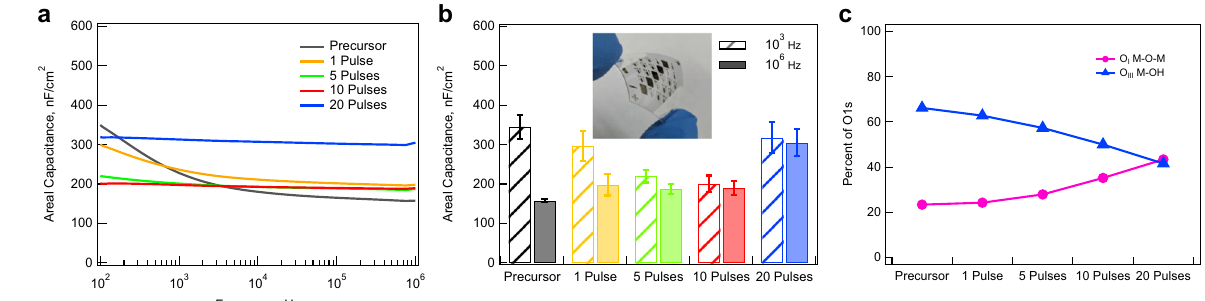
Fig. 2 Dielectric properties of photonically cured ZrO 2 fi lms as a function of number of pulses. a Average areal capacitance versus frequency of MIM capacitors made from the dried ZrO 2 precursor and from photonically cured fi lms (6.32 J/cm 2 per pulse, 20 ms pulse length, 0.2 Hz repetition rate) using 1 – 20 pulses. b Bar graph showing the low-frequency (10 2 Hz, hashed bars) and high-frequency (10 6 Hz, solid bars) areal capacitance for each condition in a with a photo of a completed device as the inset. Error bars represent standard deviation with n ≥ 5 for each measurement. c Percent contribution to the O1s peak in XPS of O I (magenta, ~530.0 eV, attributed to M – O – M bonding) and O III (blue, ~532.6 eV, attributed to M – OH bonding) versus number of pulses at fi xed 20 ms pulse